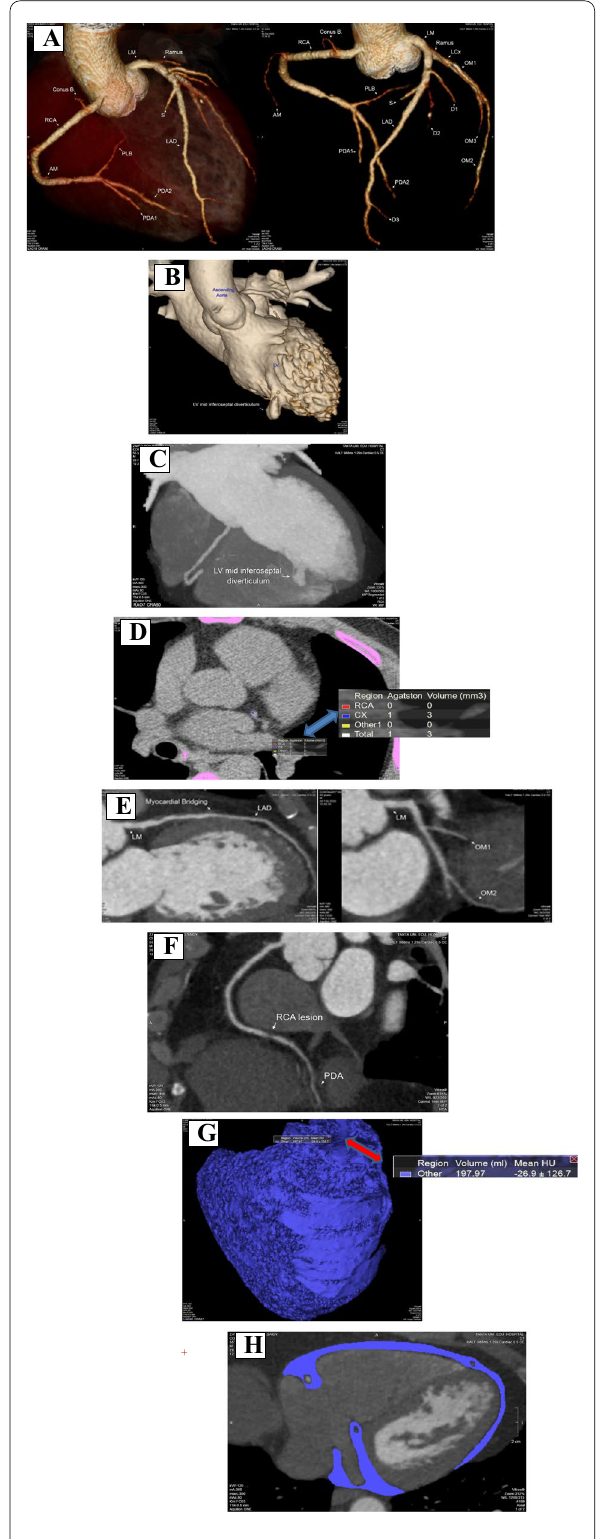
Fig. 2 A – H images: 54‑year‑old male patient (BMI 30.8), smoker, = non‑hypertensive and non‑diabetic; and complaining of chest pain. Echocardiography revealed good systolic function (EF 67%), and = no regional wall motion abnormalities. A Two different views of 3D volume rendered images showing normal origin of coronary arteries with right dominant circulation. B 3D volume rendered image and C Axial maximum intensity projection image showing LV mid‑inferoseptal divertiruclum. D Axial noncontrast curved planar reformatted image showing calcium score (1) only at LCx. E Two axial curved planar reformatted images showing atherosclerotic LM and LAD, with soft eccentric plaque with positive remolding is seen at LAD proximal segment exerting moderate stenosis (50%, length 14 mm) displaying napkin ring sign (vulnerable plaque), and = atherosclerotic LCx, OM1 and OM2, with no significant disease. Also, LAD mid‑segment has superficial intra‑myocardial course for about 13.4 mm being covered with 2.3 mm myocardial tissue without luminal compression. F Coronal curved planar reformatted image showing atherosclerotic RCA and PDA. A soft ulcerated concentric plaque is seen at RCA distal segment exerting severe stenosis (80%, length 15 mm). G 3D volume rendered image and (H) 2D axial = multiplanar reformatted image showing epicardial fat volume (197 cm 3 )